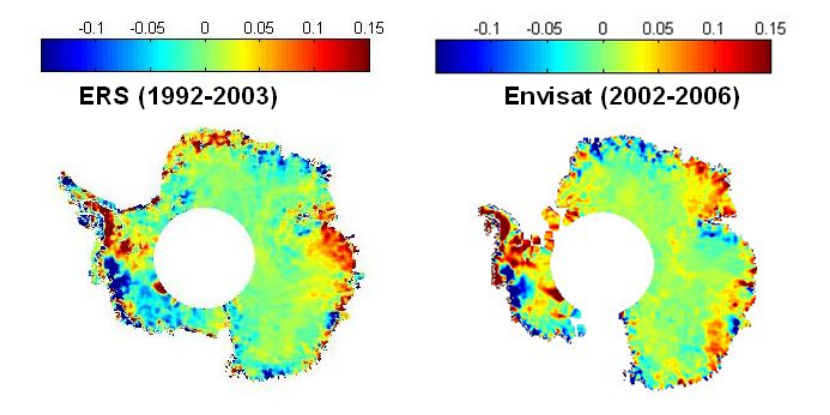
Figure 10. Mass balance of the Antarctic ice sheet (in m/yr) updated from [18], for